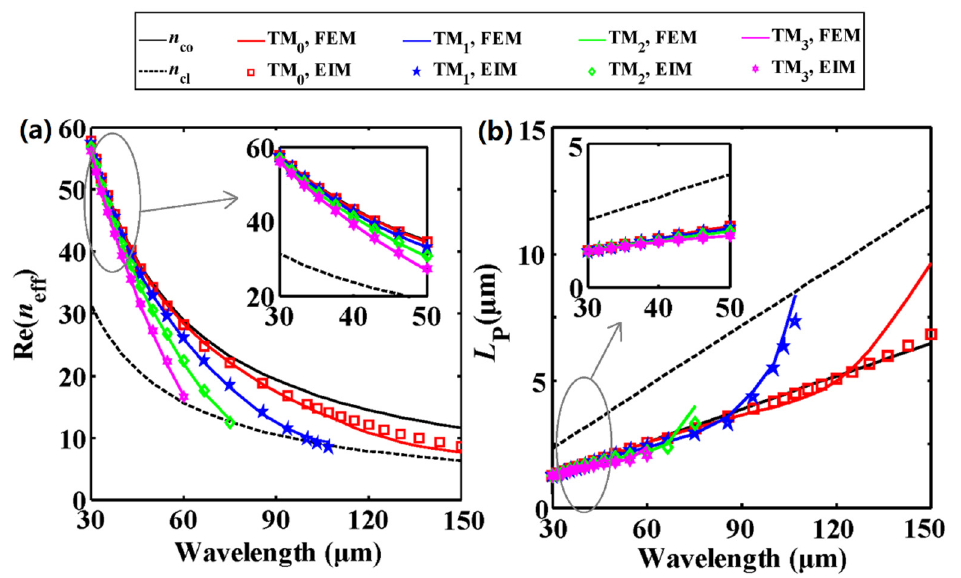
Figure 3. ( a ) Effective mode indices and ( b ) propagation lengths of the SP modes in DLGSPWG. The insets of ( a ) and ( b ) show the details at shorter wavelengths. Solid lines for FEM, and symbols for the EIM calculations. The solid and dashed black lines represent n co and n cl . w = 4 μ m, h = 2 μ m, E F = 0.6 eV.